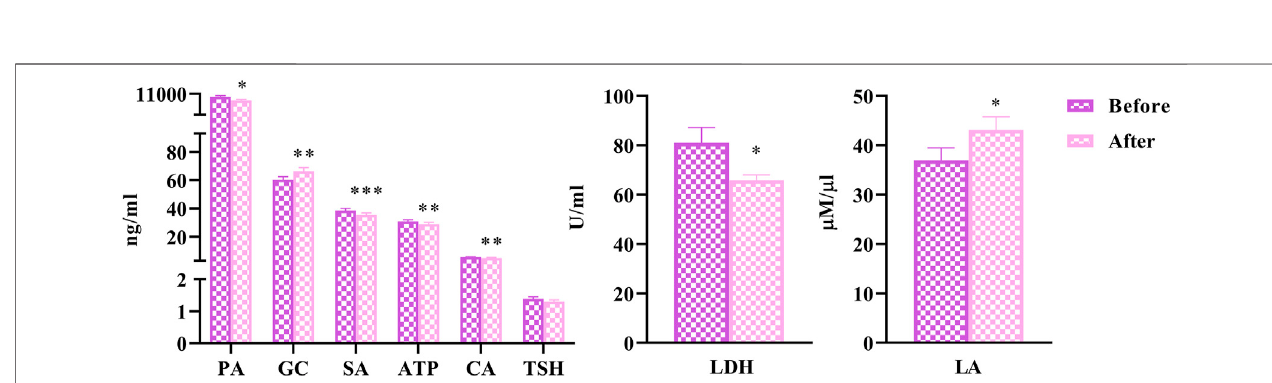
FIGURE 2 | The changes of energy metabolism factors before and after HLJDD intervention (Before) Oral disease group (After) HLJDD intervention group (* p < 0.05, ** p < 0.01, *** p < 0.001).